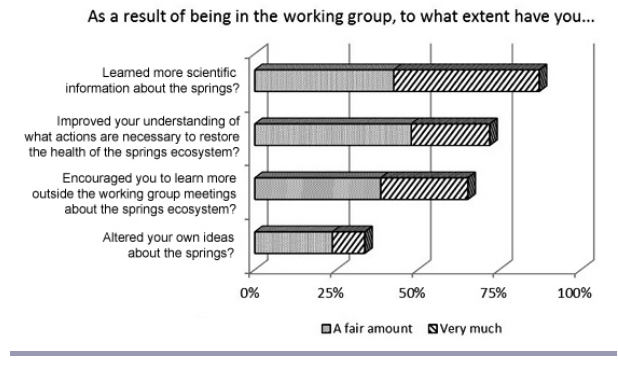
Fig. 1 . Respondent perceptions of impacts regarding mental model building.